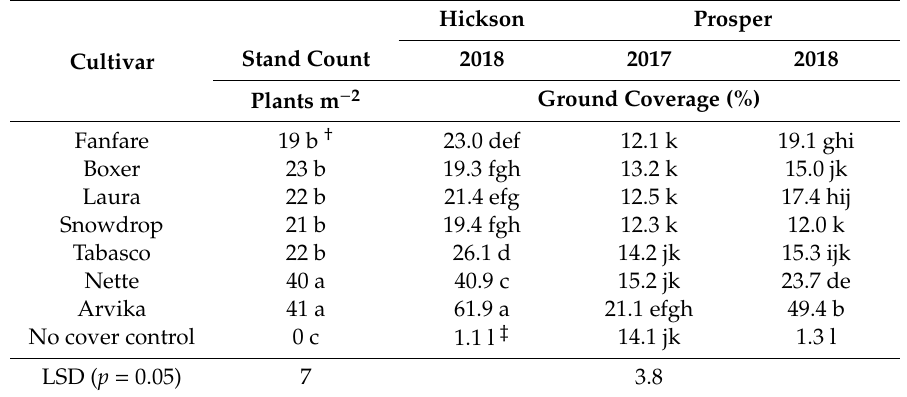
Table 5. Plant stand count averaged across four environments and ground coverage for each cultivar in each environment at Hickson and Prosper, ND, USA, in 2017 and 2018.